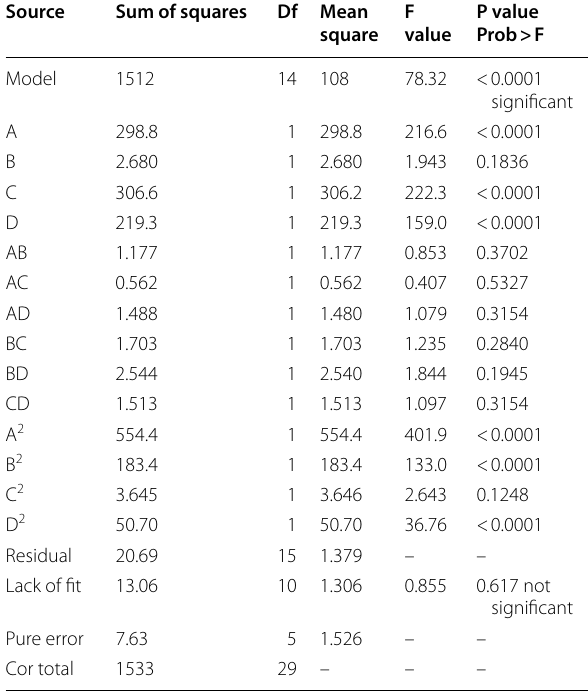
Table 5 ANOVA of Response Surface Quadratic